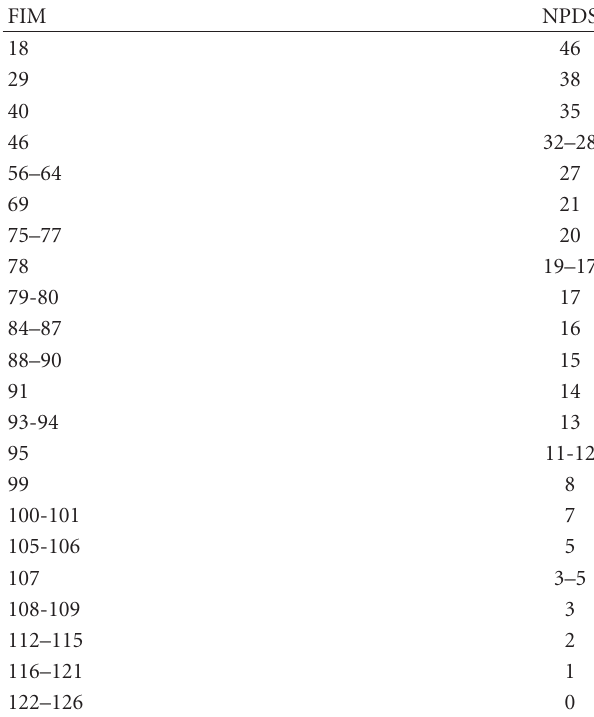
Table 3: The rank-transformable pattern of agreement (RTPA) of the total score of FIM and the BCN section of NPDS